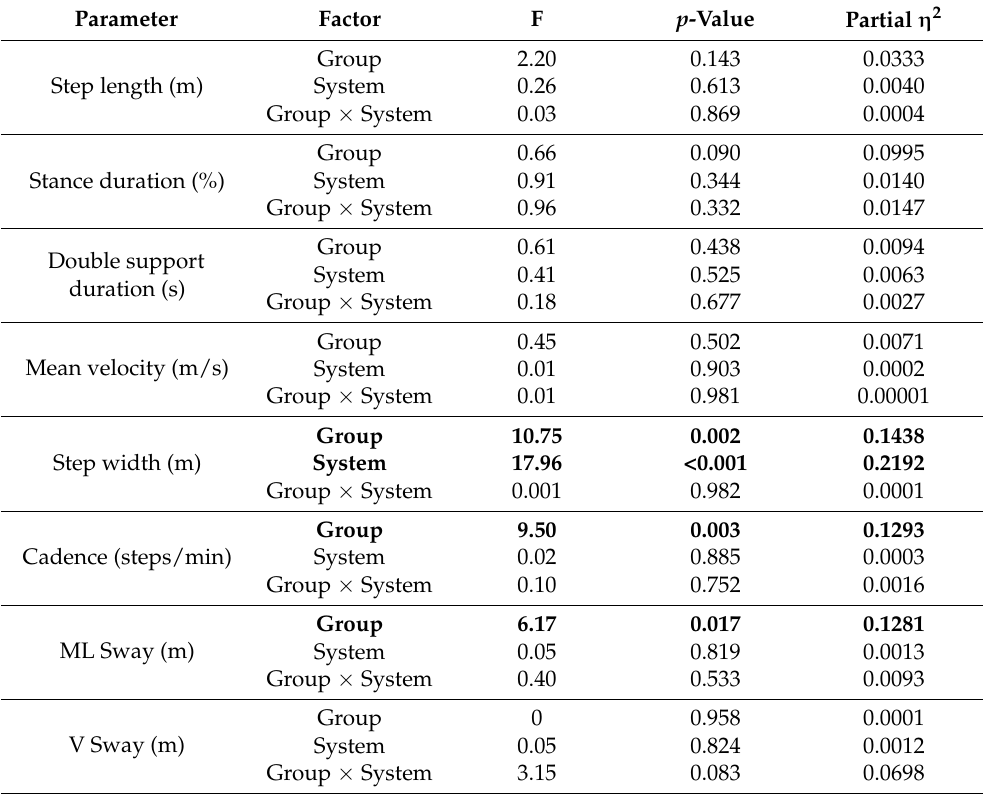
Table 4. Results of the “between-subject” analysis of Group (PD and PS groups), the “within-subject” analysis of System (3D-GA and RGB-D systems), and the Group × System interaction for spatio- temporal and COM parameters. Statistically significant data are highlighted in